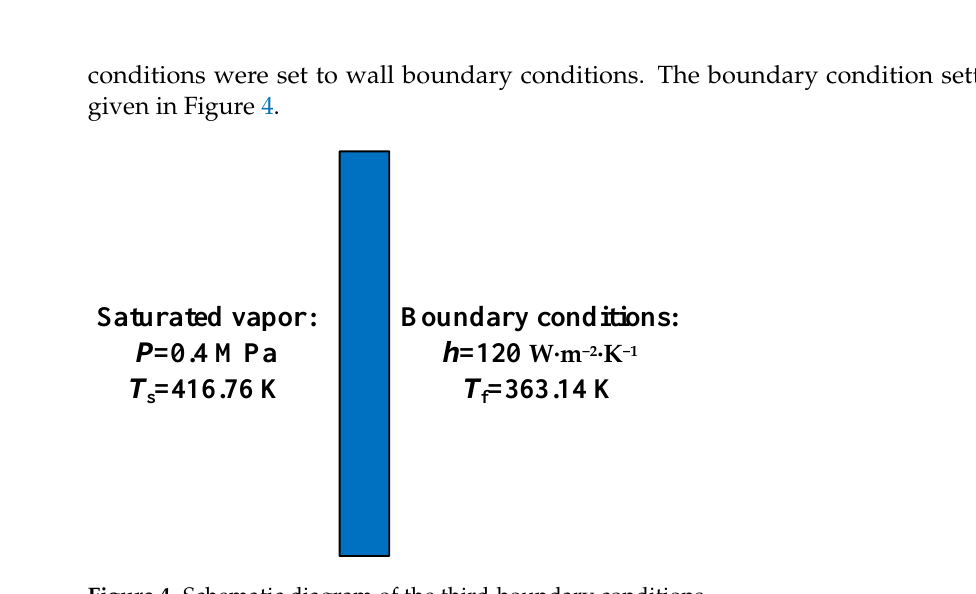
Figure 4. Schematic diagram of the third-boundary conditions.